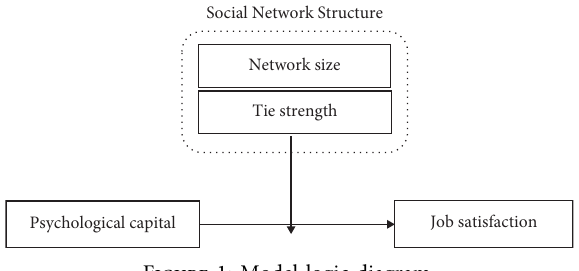
Figure 1: Model logic